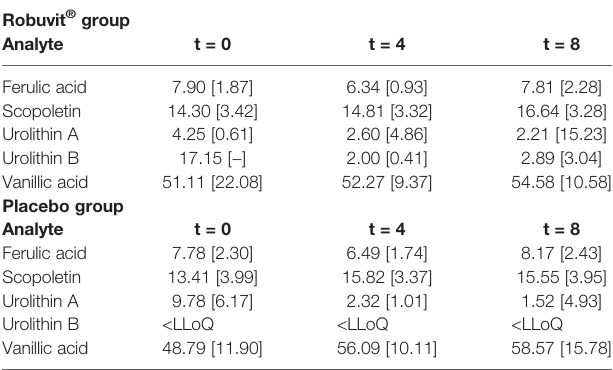
TABLE 3 | Blood cell concentrations after intake of Robuvit ® or placebo. Robuvit ® group